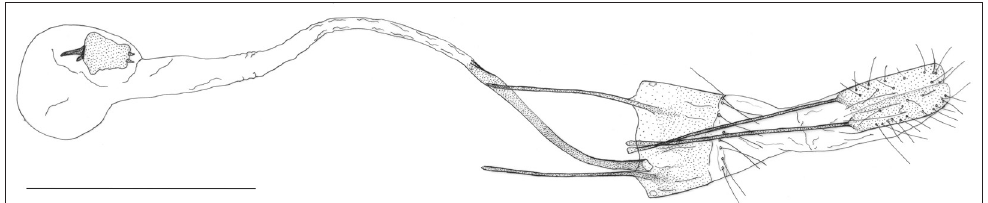
E. gemerensis|TLMF Lep 20508|658bp|Slovensky raj Vernarska tiesnava E. gemerensis|TLMF Lep 05168|633bp|NP Slovensky kras PR Dulova E. gemerensis|TLMF Lep 05167|658bp|NP Slovensky kras PR Dulova E. gemerensis|TLMF Lep 05169|658bp|Muran-hrad 0.001 = 0.1% Figure 3. A neighbour-joining tree of four barcoded specimens of Eulamprotes gemerensis with a scale bar showing genetic distance between